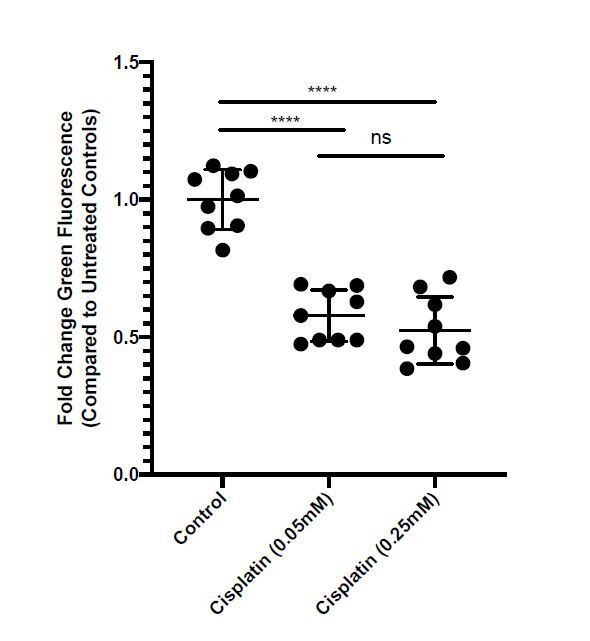
Cisplatin treatment results in damage to zebrafish neuromast structures that is detectable using a plate reader.Groups of 72 hour post-fertilization (hpf) casperzebrafish larvae were treated with either vehicle control, 0.05 or 0.25mM cisplatin for 24hr. At the endpoint, larvae were stained with 2μM YO-PRO1 for 1hr, rinsed, then allotted 5X well in a 96-well plate. Fluorescence values were then acquired using a plate reader. Data is presented as fold change in comparison with untreated controls. Each data point represents the average of 3 reads of an individual well that contained 5 larvae. ****=p<0.0001, as per one-way ANOVA with a Tukey post-test. N=2 replicates with at least 4 wells in each treatment.